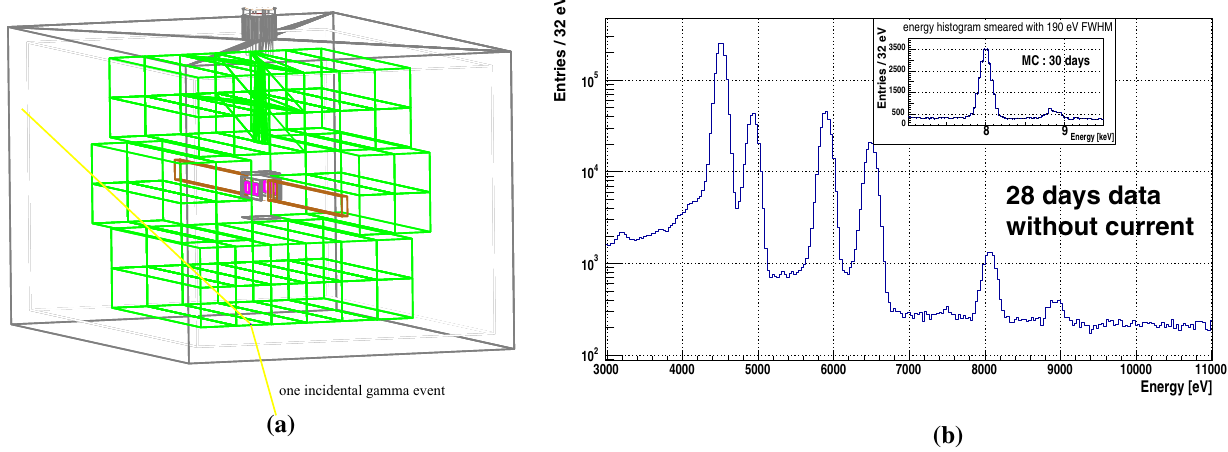
Fig. 9 a The geometry of the setup used in the Geant4 simulation; b a comparison between the 28 days of no current data and the simulated energy spectrum (the inset) of six SDDs from 30 days of data tak-